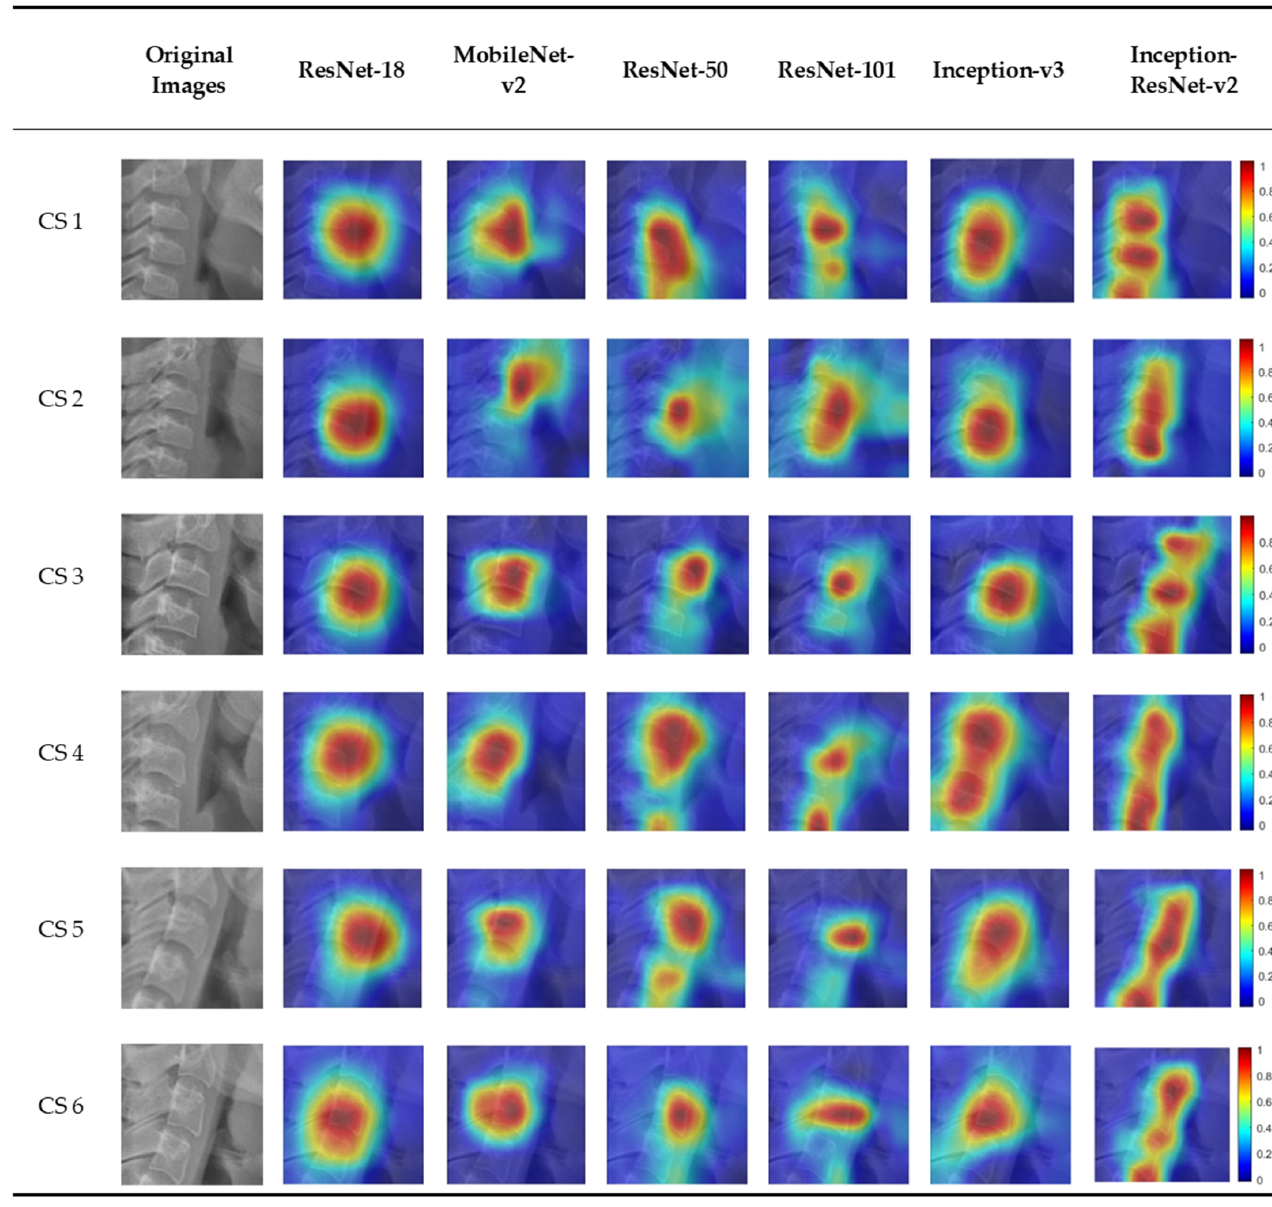
Figure 4. An example of Grad-CAMs of the CNN-based deep learning models.